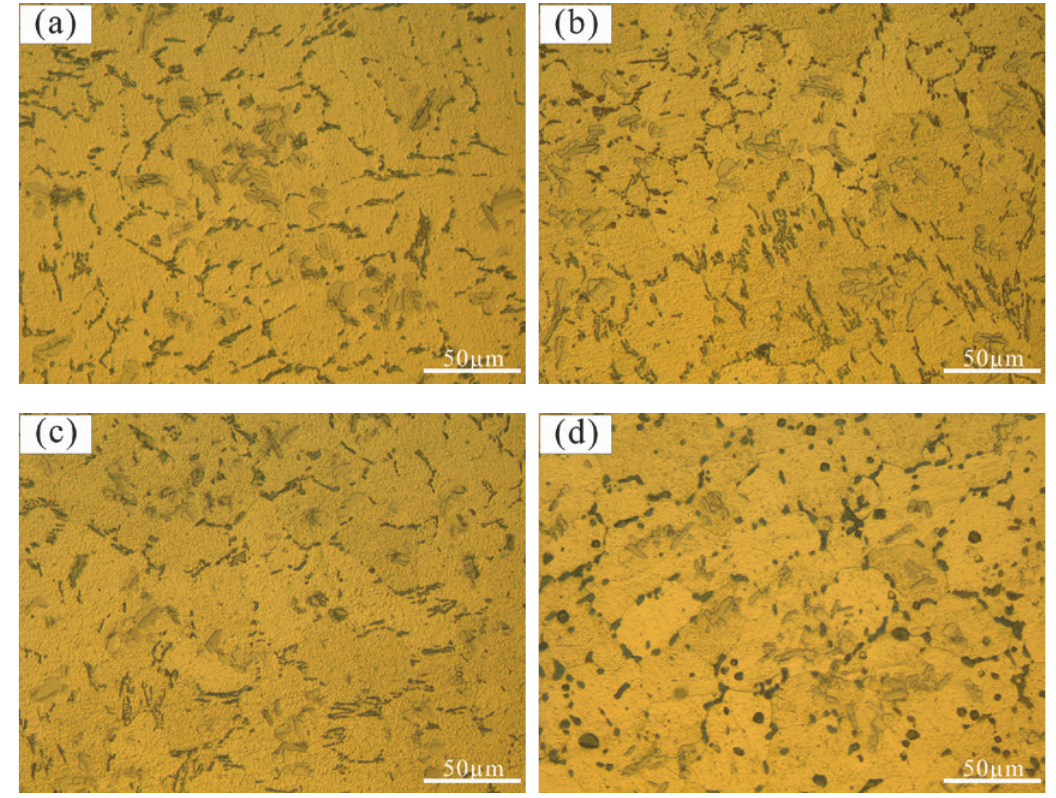
Fig. 3: Microstructures of Ti-containing alloy 2618 homogenized at different temperature for 24 h: (a) 743 K; (b) 763 K; (c) 773 K; (d) 783 K